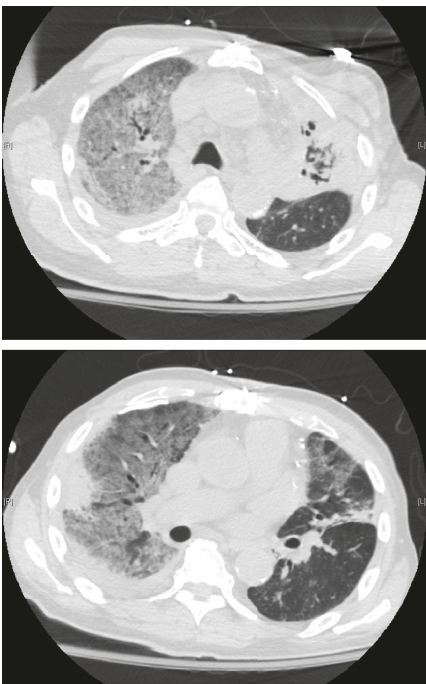
Figure 3: CTchest scan on hospital day 6: persistent consolidation in the left upper lobe with bronchiectasis and in the right upper lobe again noted; new scattered areas of ground glass are seen in both lungs, particularly affecting the right upper